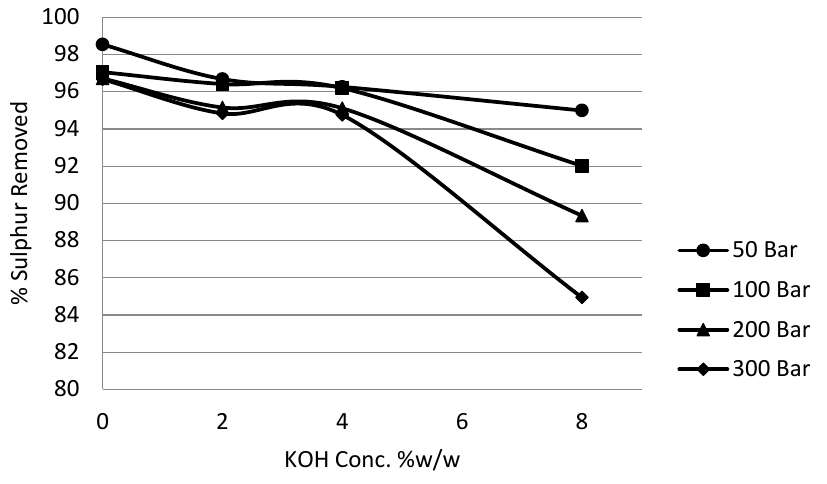
Figure 16. Effect of KOH concentration on heating value recovery.